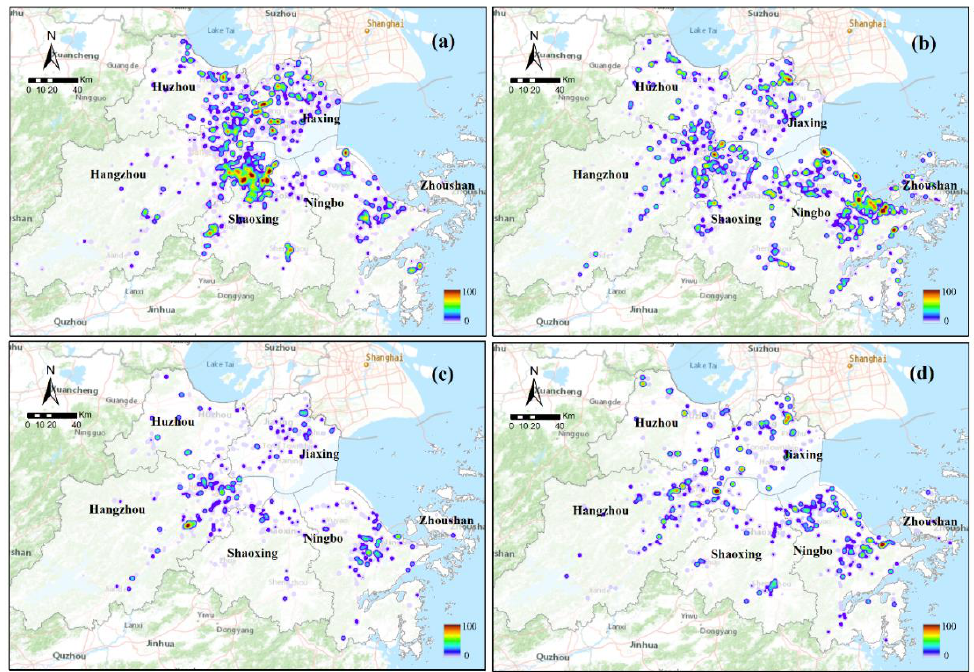
Figure 12. Spatial distributions of typical industrial structures in 2015: ( a ) textile and clothing manufacturing; ( b ) equipment manufacturing; ( c ) paper industry; ( d ) electronic information industry.